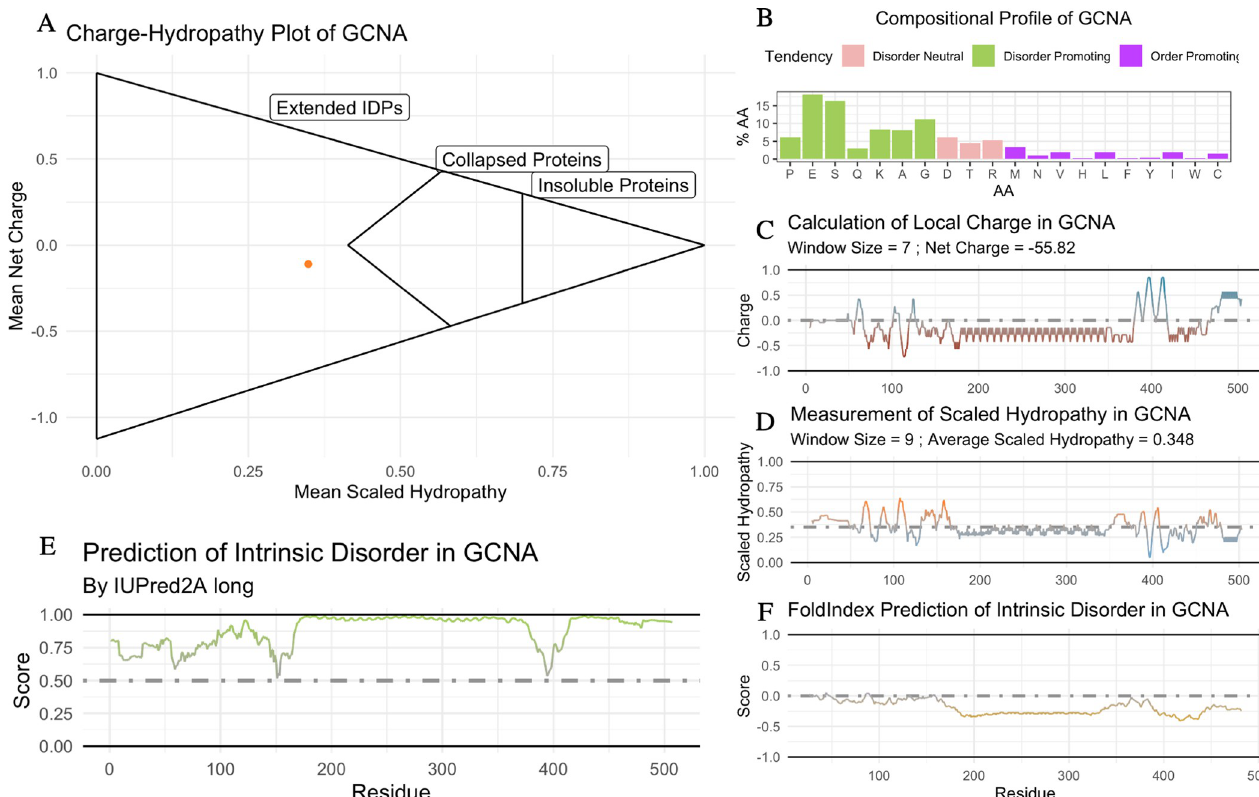
Fig 3. The idprofile of mouse GCNA shows prediction of an entirely disordered IDP. (A) Charge-hydropathy plot of GCNA predicts a disordered protein. Method are described in [16]. Mean Scaled Hydropathy calculated with the Kyte and Doolittle measurement of hydropathy [33], scaled to Arg = 0.0 and Ile = 1.0. Mean Net Charge calculated with IPC_protein pKa values [34]. Cutoff equation is < Charge > = ± 2.785 < Hydropathy > ± 1.151 as described previously [18]. Proteins are considered insoluble when < Hydropathy > � 0.7. (B) Structural tendency plot shows GCNA is enriched in disorder-promoting residues. Disorder-promoting residues (P, E, S, Q, K, A, and G) in green; order-promoting residues (M, N, V, H, L, F, Y, I, W, and C) in purple; disorder-neutral residues (D, T, and R) in pink [35]. (C) Local Charge Plot shows an acidic C-terminus. The local charge is the average of a 7 amino acid wide sliding window, calculated with the IPC_protein pKa values [34]. (D) Local Hydropathy Plot shows a C-terminus deficient in hydrophobic residues. The local hydropathy is the average of a 9 amino acid wide sliding window, calculated with the scaled Kyte and Doolittle measurement of hydropathy [33]. (E) IUPred2 predicts a C- terminal IDR in GCNA [23, 24]. Residues with a score 0.0–0.5 are predicted to be ordered, regions 0.5–1.0 are predicted to be disordered. (F) FoldIndex predicts a C-terminal IDR in GCNA [36]. Residues with a score 0.0 –+1.0 are predicted to be ordered, regions -1.0–0.0 are predicted to be disordered.